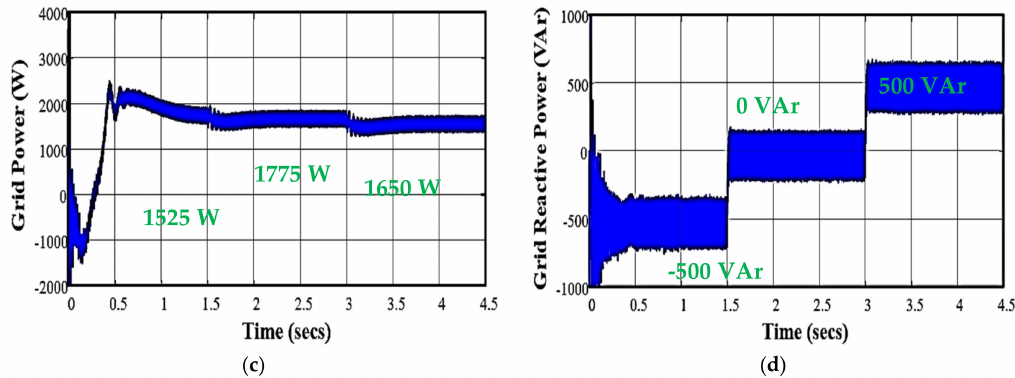
Figure 12. System performance under constant speed control and variable reactive power reference: ( a ) input mechanical power, Pm ( b ) control machine power, Pc , ( c ) grid power, P g ( d ) grid reactive power, Q g